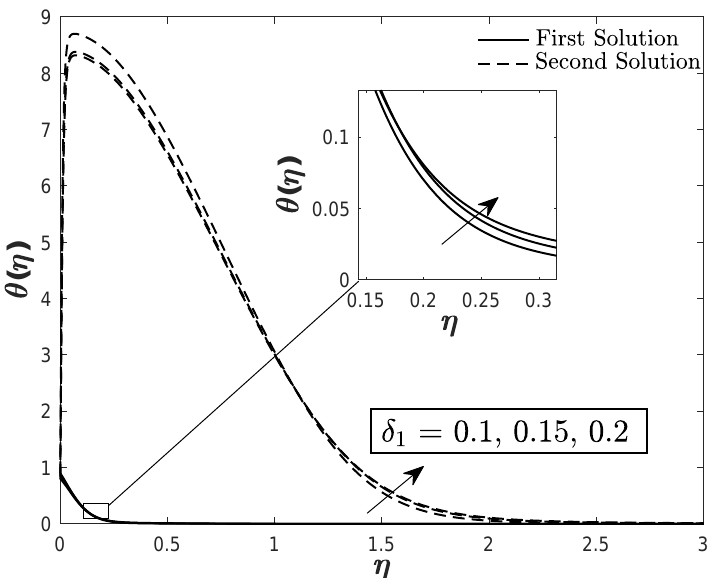
Figure 9. Effect of thermal stratification δ 1 on the temperature